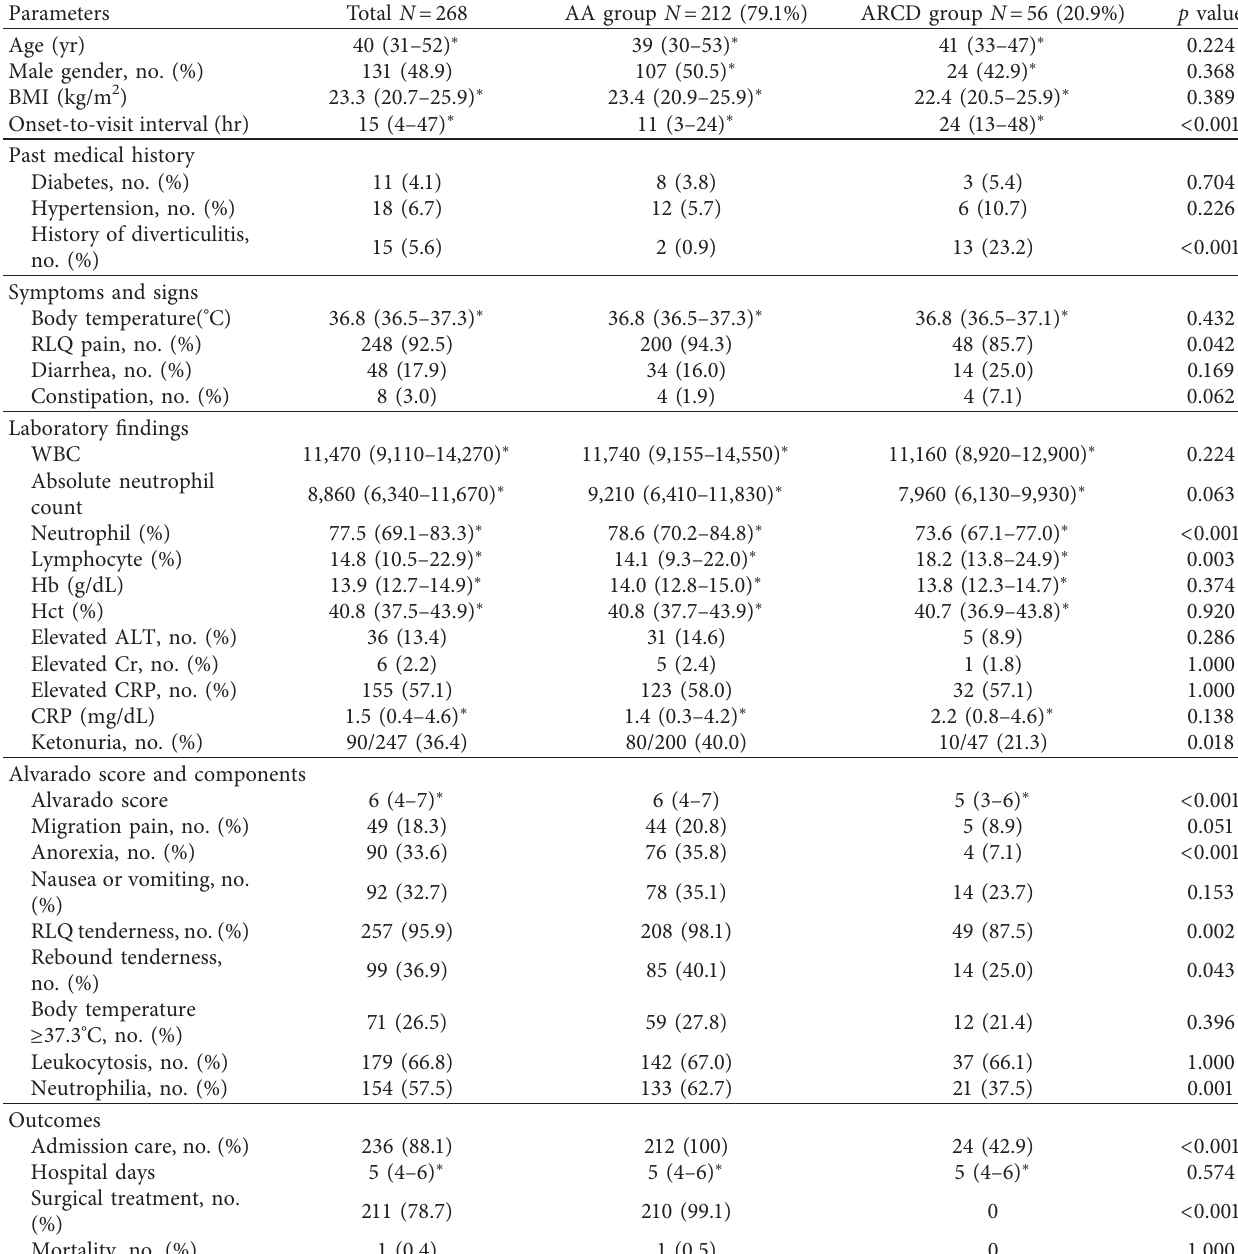
Table 2: General characteristics.